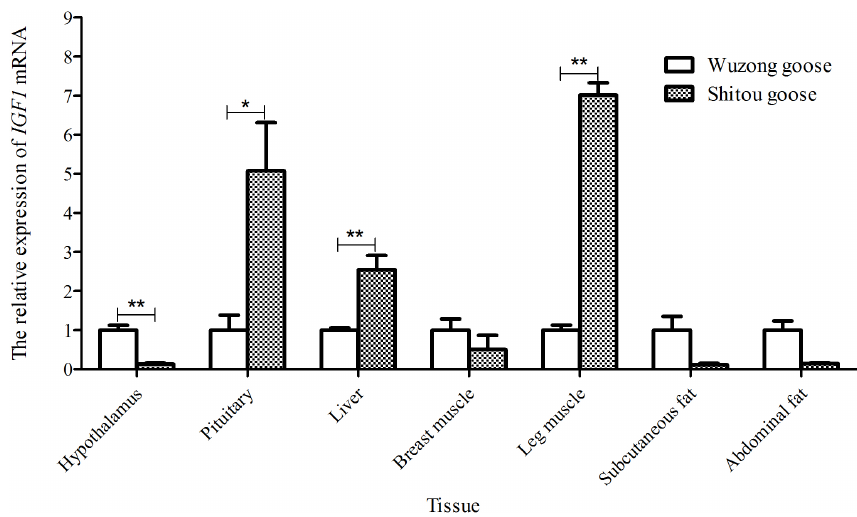
Figure 7. Differential expression of the IGF1 gene in different tissues between a 5-week-old Shitou goose and Wuzong